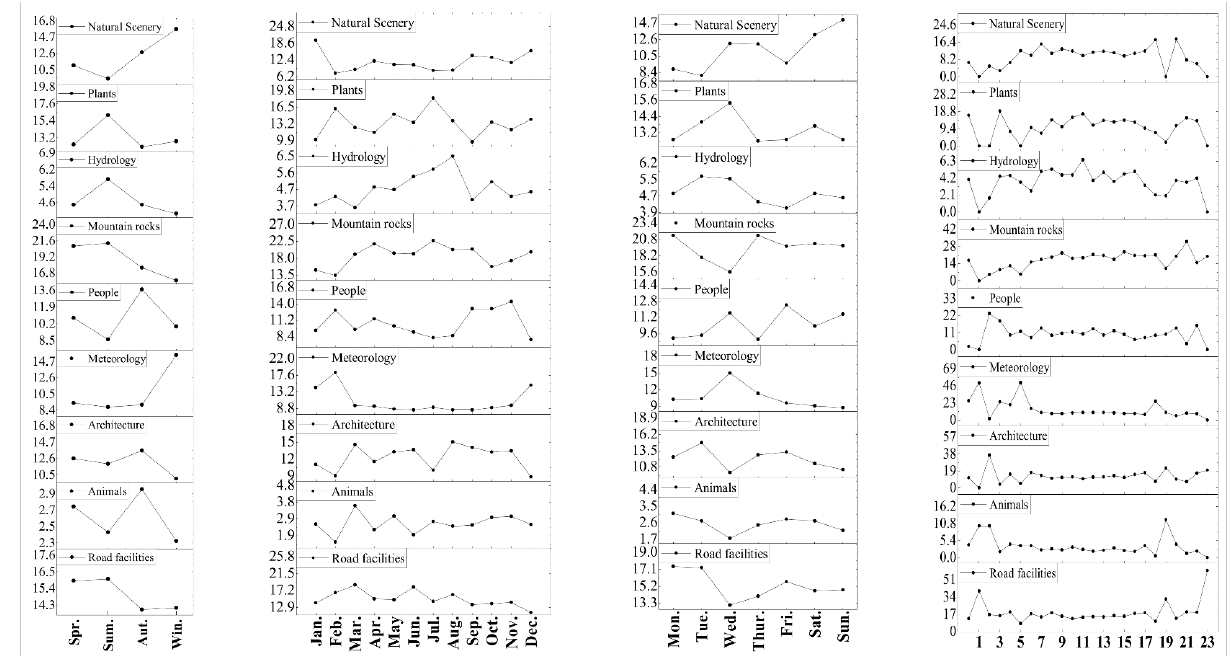
Figure 5. Tourists’ photos focus type on a scale of seasons, months, weeks, and